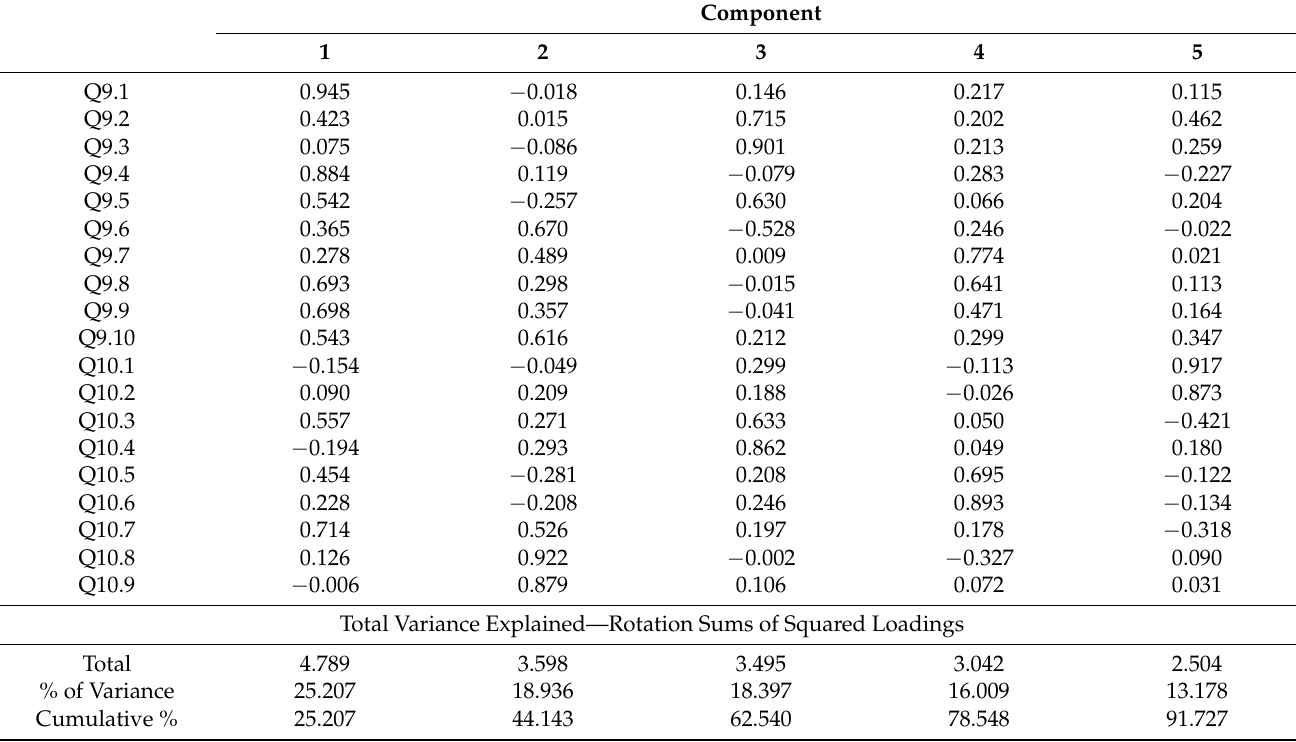
Table A5. Eigenvalues and proportion of the total variance in 9 groups of collective entrepreneurship, as explained by the first three principal components for the original 19 traits and the correlation coefficients between these traits and the first three PCs on for questions Q9 and Q10.